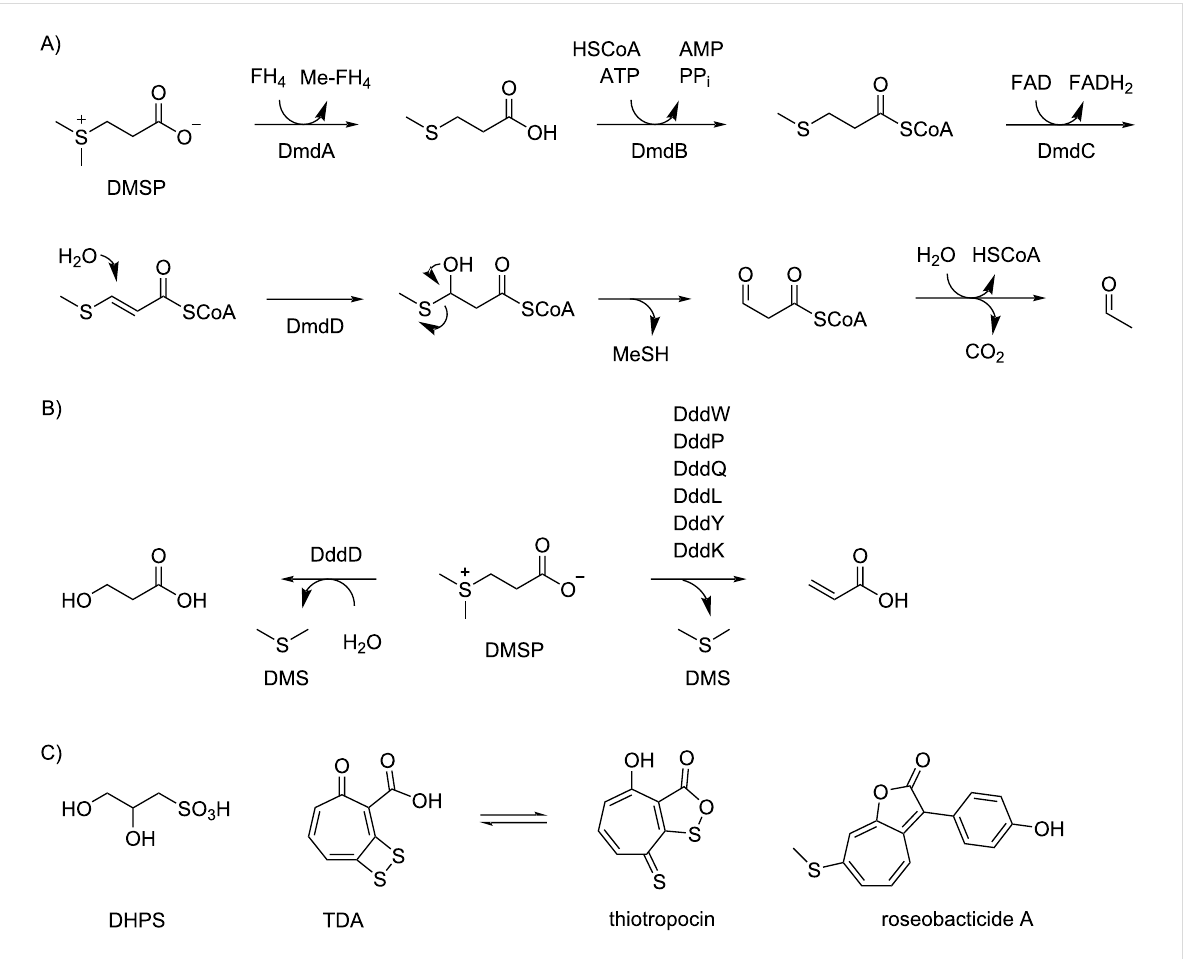
Scheme 1: Sulfur metabolism in bacteria from the roseobacter group. A) DMSP demethylation by DmdABCD, B) DMSP hydrolysis by DddP and lysis by DddW, DddP, DddQ, DddL, DddY or DddK, and C) structures of DHPS and sulfur-containing secondary